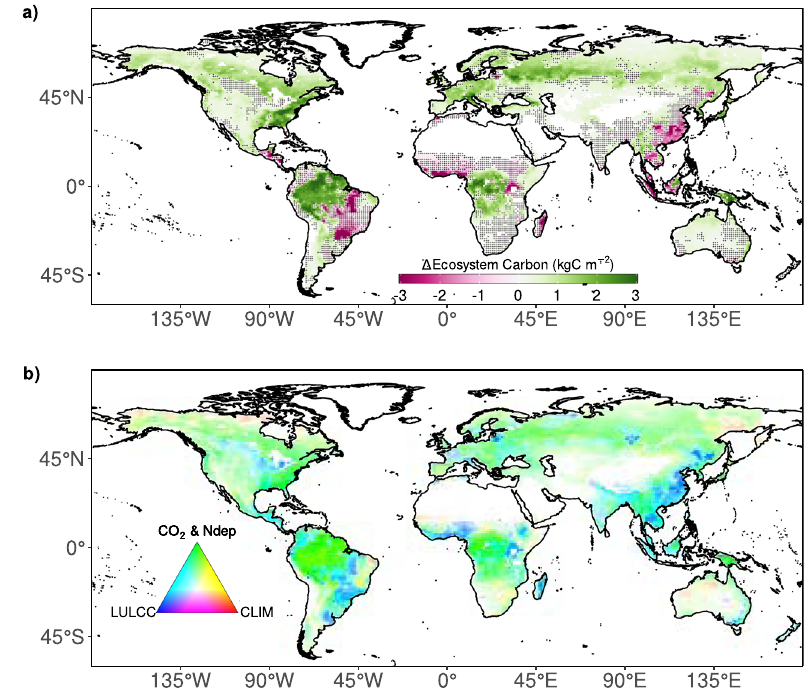
Fig. 2 | Driver attribution to spatial changes in total ecosystem carbon. Maps showthemulti-modelmean a netchangeinecosystem(vegetationandsoil)carbon (kgCm − 2 )from1959 – 2020and b the contribution of eachdriver to overallchange; CO 2 and N deposition (green), climate (red), and land-use and land cover change